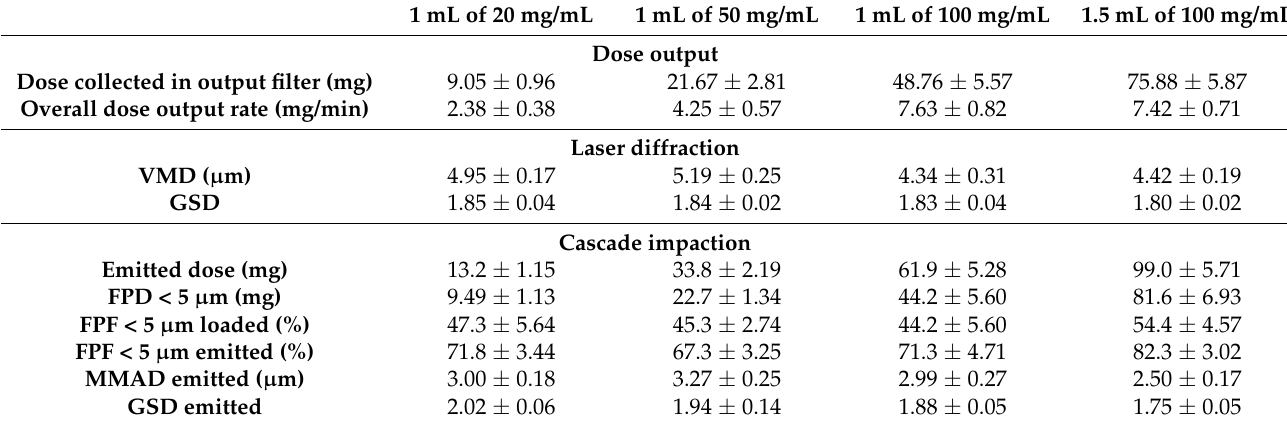
Table 7. Summary of the key parameters measured in the dose output, laser diffraction, and cascade impaction experiments. 1 mL of 20 mg/mL 1 mL of 50 mg/mL 1 mL of 100